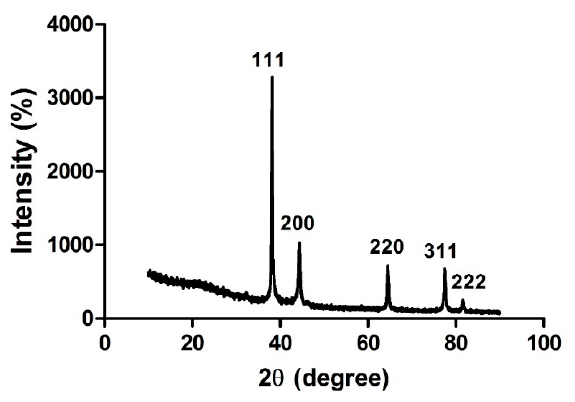
Figure 3. X-ray diffraction pattern of Coptidis rhizome -mediated biosynthesized silver nanoparticles. Table 1. Average particle size of Coptidis rhizome -mediated biosynthesized AgNPs calculated using Scherrer’s